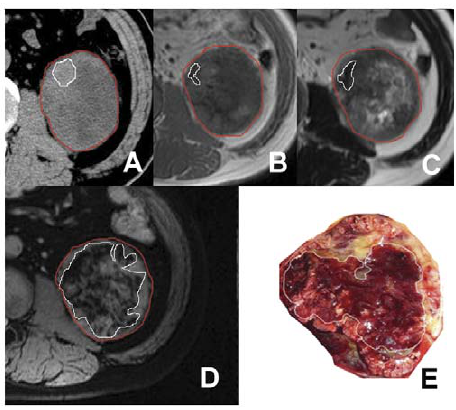
Figure 3. Left renal ccRCC with a grade III tumor in the Fuhrman system. In axial CT image, a patchy hyperattenuating area (area in white boundary) is seen in the tumor (area demarcated by the red boundary) (A). A hemorrhage lesion with hypointensity (area in white boundary) is seen on T1WI (B) and T2WI (C) within the tumor region (area demarcated by the red boundary). On SWI (D), an extensive hemorrhage lesion with hypointensity (area demarcated by the white boundary) is present in the tumor region. In gross pathology (E), an extensive hemorrhagic lesion (area demarcated by the white boundary) is seen in the tumor.